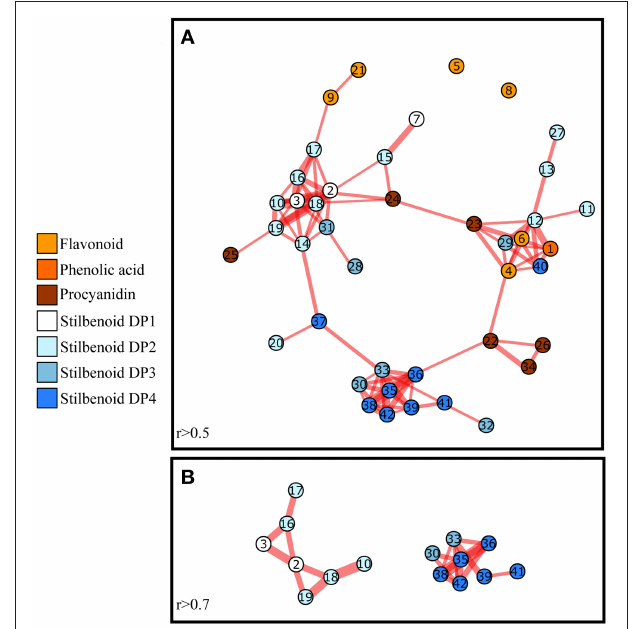
FIGURE 7 | Similarity index of the two dendrograms obtained from polyphenols in 2013 and SSR markers as function of k clusters selected. network analysis showed a fine control of structurally related polyphenols.